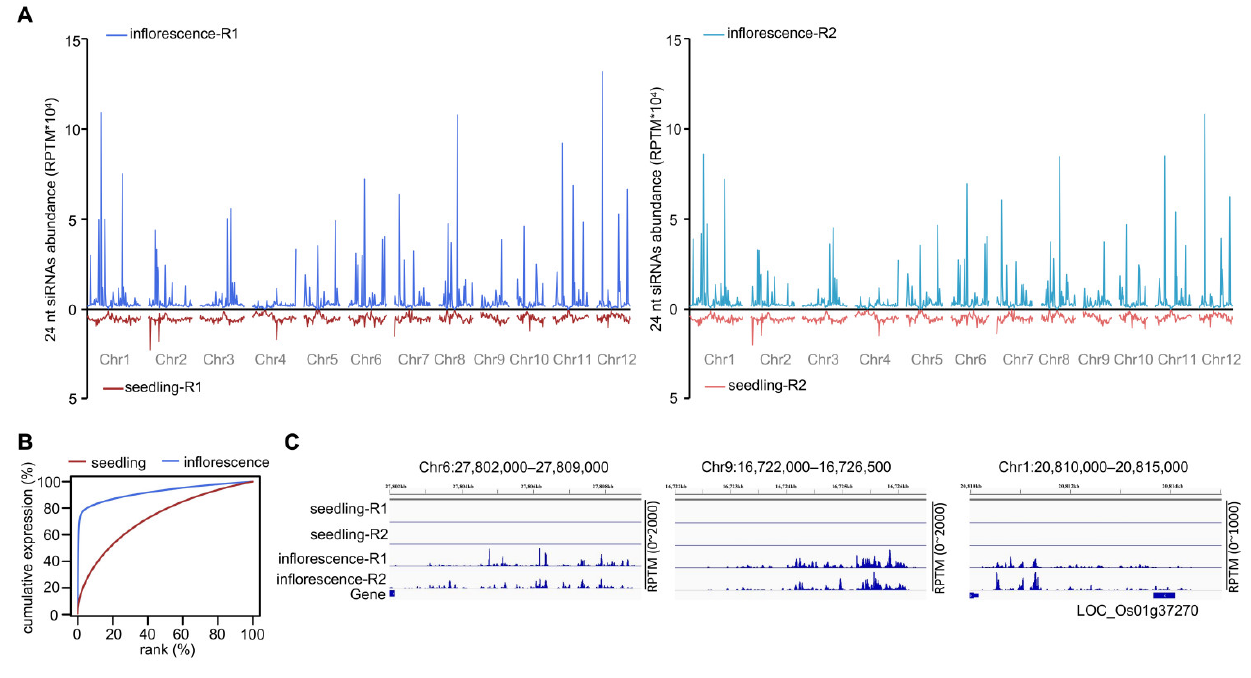
Figure 1. Rice inflorescences produce bill-siRNAs. ( A ) Comparison of 24 nt siRNA distributions on the rice genome between inflorescences and seedlings in Nipponbare. Y-axis indicates siRNA abundance with RPTM within 500 kb windows. ( B ) Cumulative expression plot of 24 nt siRNAs in inflorescences and seedlings in Nipponbare. The abundance of each cluster is indicated by RPTM based on two replicates; their cumulative expression was ranked and plotted. siRNA clusters were analyzed if their abundance ≥ 12 RPTM in combined replicates (n = 20,200 in inflorescence, n = 57,424 in seedling). ( C ) Screen shots of Integrative Genomics Viewer (IGV) showed the abundance of bill-siRNAs in inflorescences and seedlings.